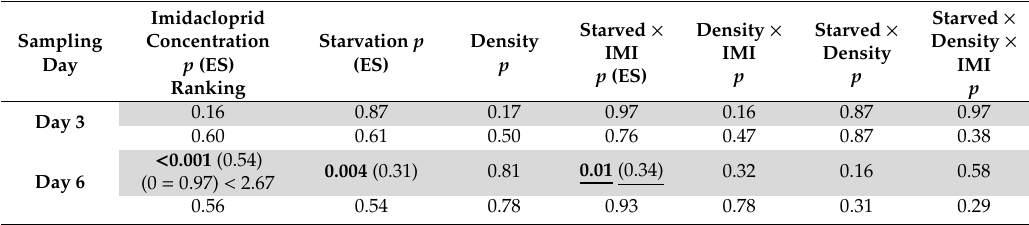
Table 4. Results of three-way ANOVAs comparing responses between experimental treatments for ‘immobility’ (grey) and ‘moulting frequency’ (white). p- values < 0.05 are in bold text, and e ff ect sizes (ES; partial η 2 values; range 0–1) are given in brackets where p < 0.10. One interaction that overrode a main e ff ect of starvation (due to a larger e ff ect size) is underlined. See Table 2 for further